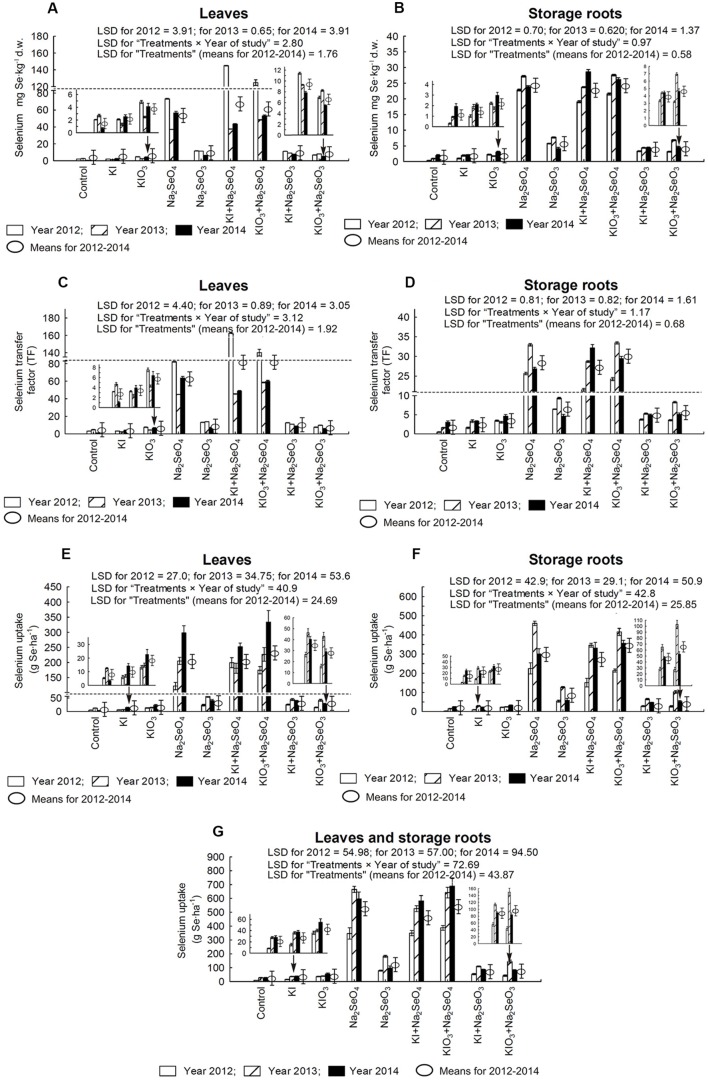
Selenium concentration in leaves (A) and storage roots (B), transfer factor (TF) of selenium to leaves (C) and storage roots (D) as well as selenium uptake by leaves (E), storage roots (F) and whole plants of carrot (G) in the years 2012–2014, depending on varying fertilization with iodine and selenium. LSD, least significant difference, p < 0.05. Bars indicate standard error; (n = 4).